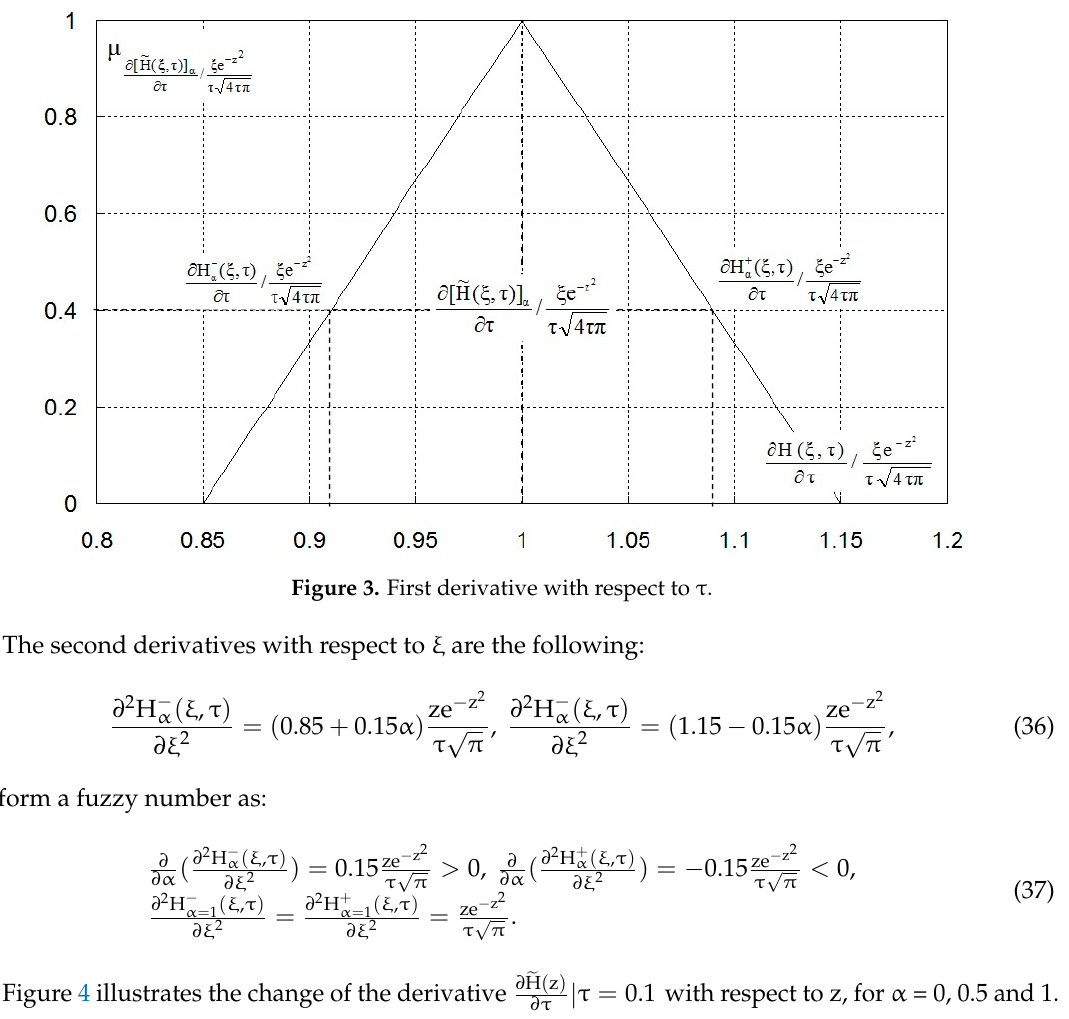
Figure 3 illustrates the first derivative with respect to τ .